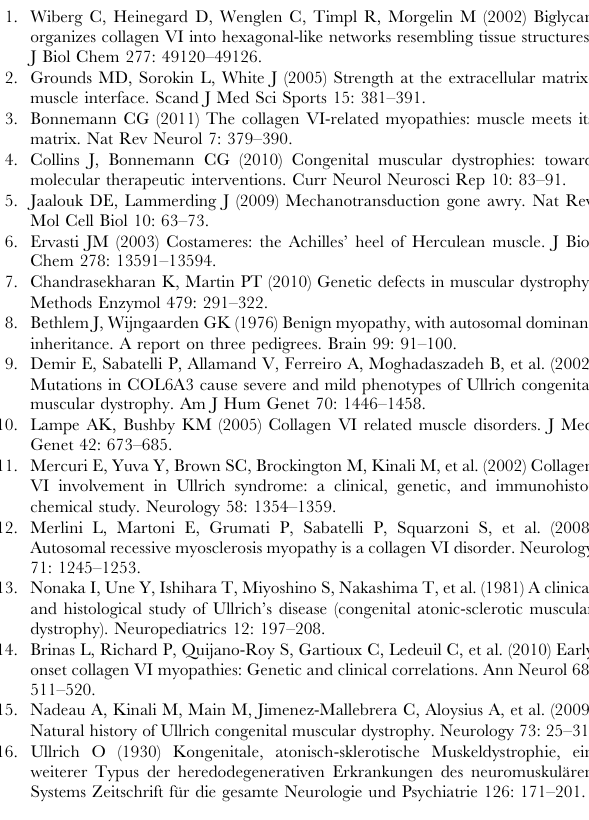
Table S1 Mass spectrometry data. Protein identifica- tion in muscle tissue by PMF and MS/MS. The spot number, the protein names, the gene name, the % of spot variation and the AC number together with MS data are listed. Data S1 Supplementary MS data. Representative